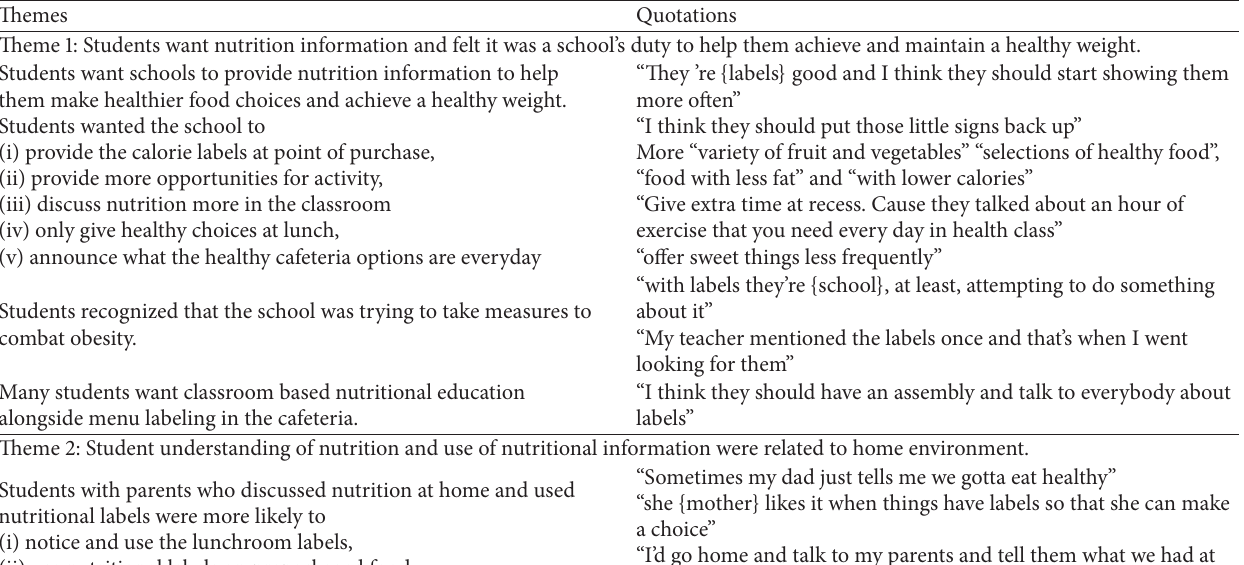
Table 3: Five significant